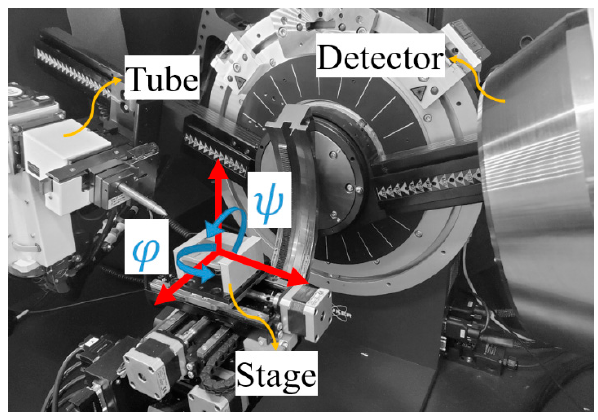
Figure 1. Sample orientation guide, defining different angles required for stress measurements with respect to the position of tube, sample and detector.